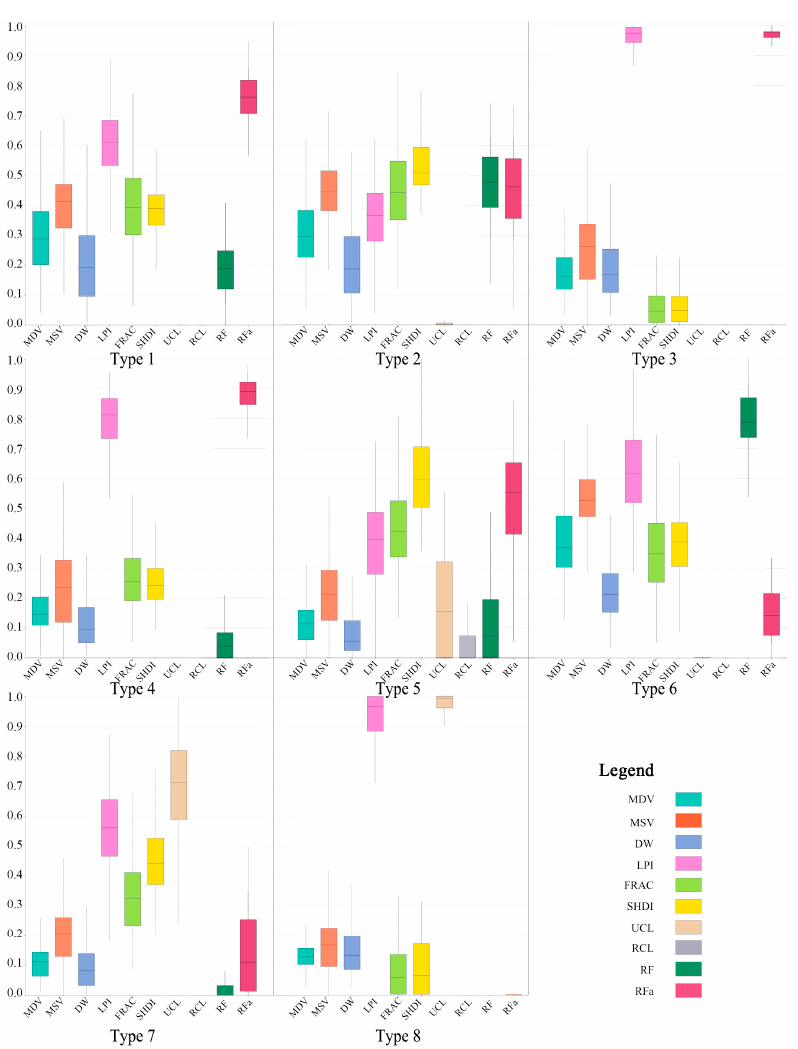
Figure 6. Cluster results of